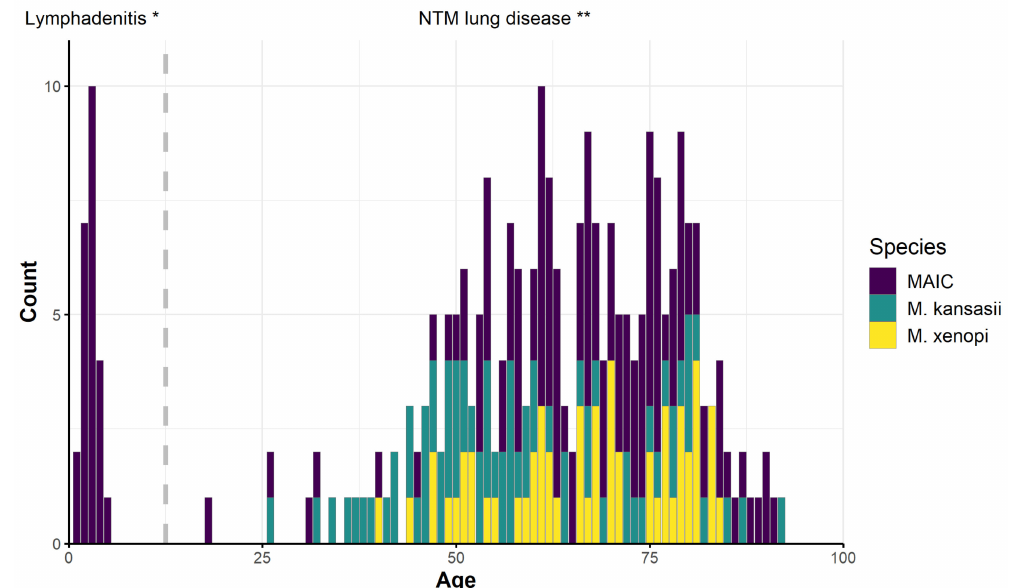
Figure 5. Type of the diseases, number of patients with the most frequent NTM complex and species, and the number of cases by age. * 100% of patients under 5 years of age su ff ered from cervical lymphadenitis; ** 98.02% of patients older than 18 years su ff ered from NTM lung diseases in the period 2012–2018. MAI C: M. avium intracellulare complex.